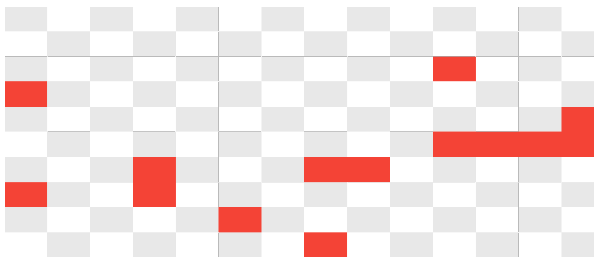
Figure 19. Grid 14 × 10 (manual — skilled operator).